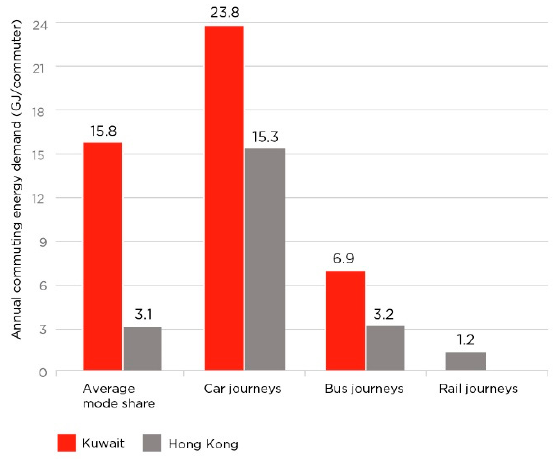
Figure 10. Daily per capita energy consumption for work journeys in Kuwait and Hong Kong.